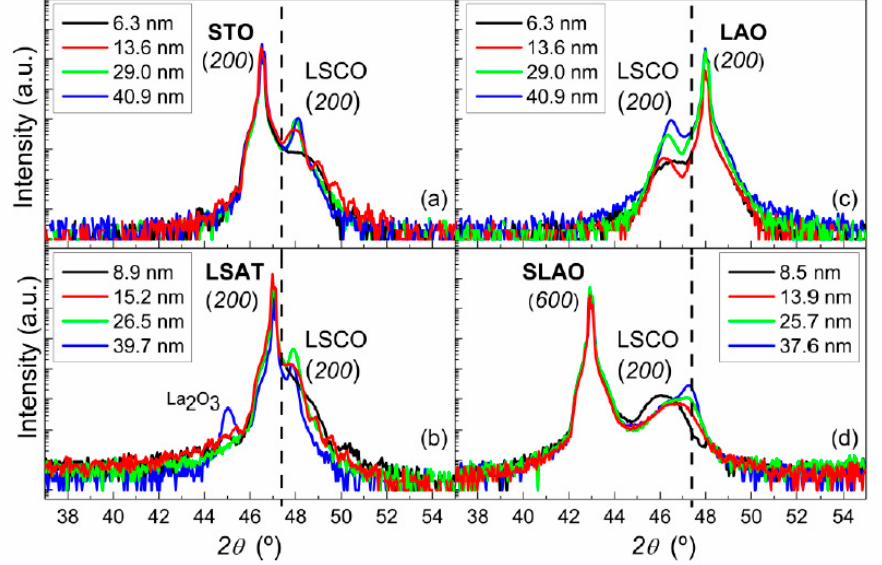
Figure 2. X-ray diffraction scans for LSCO films of various thicknesses grown on STO ( a ), Sr 0.3 La 0.7 Al 0.65 Ta 0.35 O 3 (LSAT) ( b ), LaAlO 3 (LAO) ( c ) and SLAO ( d ) substrates. Dashed lines indicate the position of the (200) peak corresponding to LSCO bulk.